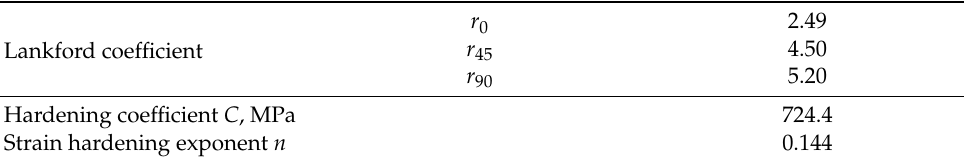
Table 6. Material data assumed in numerical